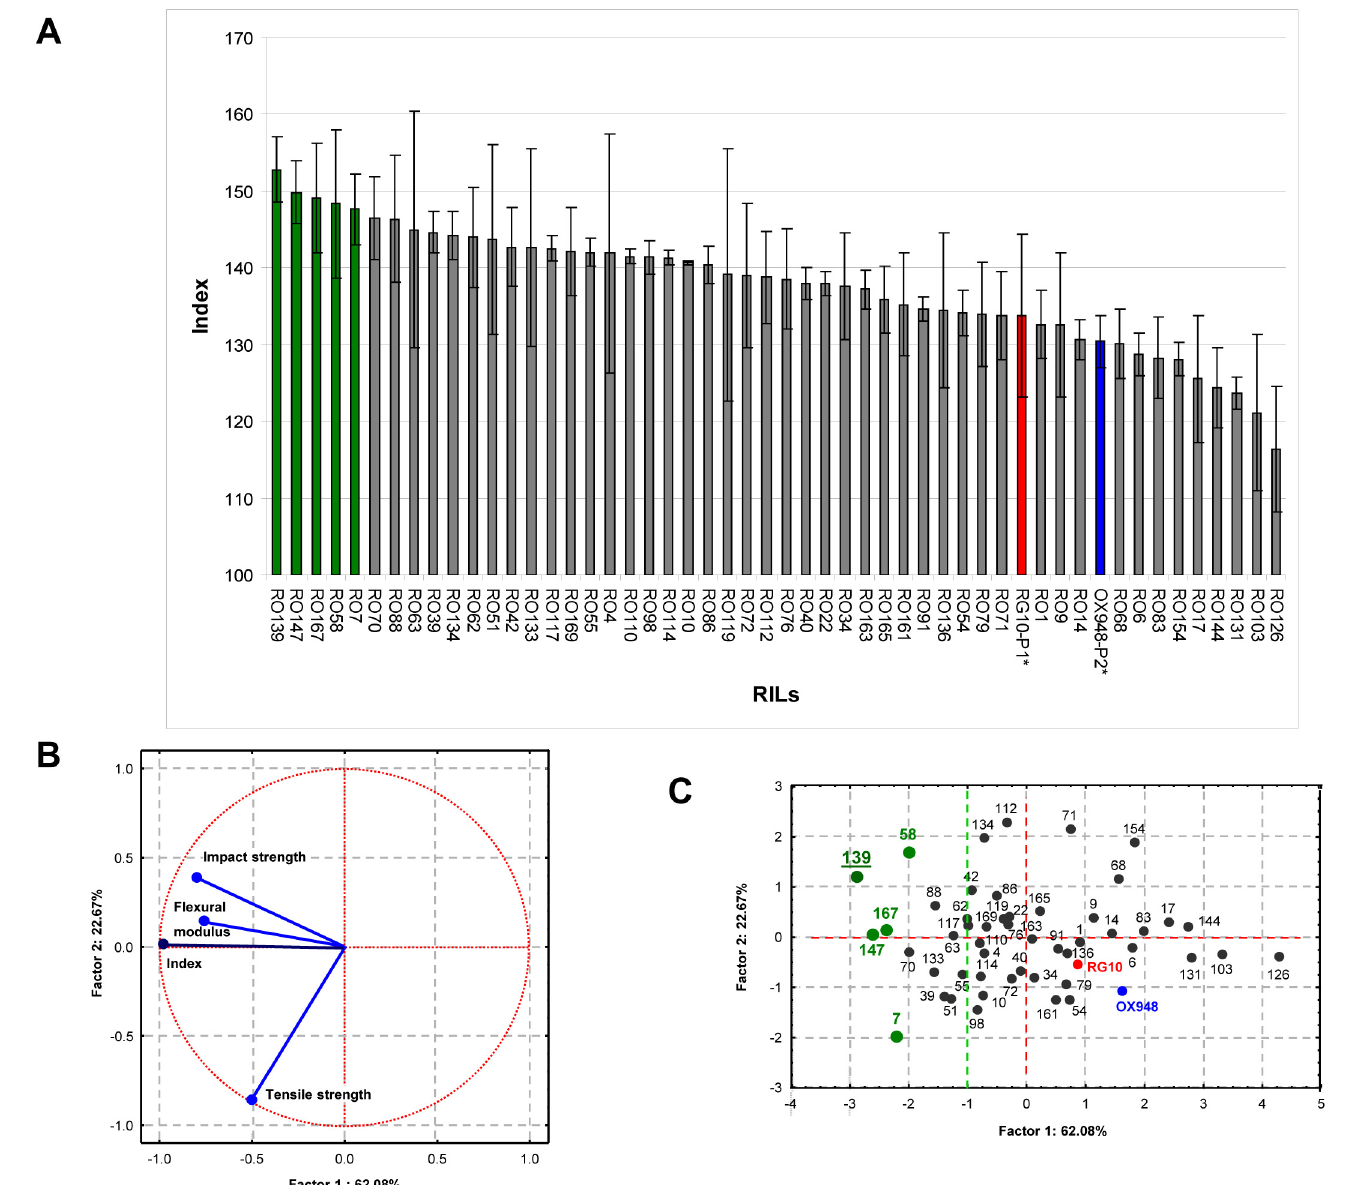
Fig 2. Mechanical properties of soybean stem fiber/polypropylene (SS/PP) composite materials. A. Index distribution. The index was calculated as Ʃ the percent difference for tensile strength from pure PP, the percent difference for flexural modulus from pure PP and the percent difference for impact strength from pure PP; B. Projection of the mechanical traits and index: factors 1x2; C. Projection of the soybean genotypes on the factor-plane: factors 1x2 explained 84.75% of the variability.